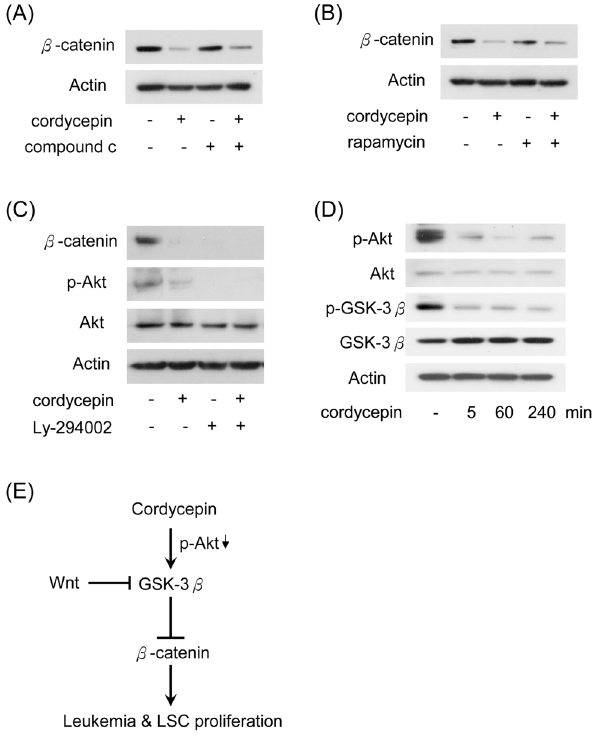
suppressed b -catenin. U937 cells were treated with cordycepin (100 m M) combined with/without (A) compound c (1 m M), (B) rapamy- cin (10 m M) and (C) Ly-294002 (20 m M) for 4 hrs. Expression level of b - catenin, Akt phosphorylated Akt (Ser473) were determined by Western blot analysis. Actin was used as loading control. (D) U937 cells were treated with cordycepin (100 m M) for 5, 60 and 240 min. Expression level of phosphorylated Akt (Ser473), Akt, phosphorylated GSK-3 b (Ser9) and GSK-3 b were determined by Western blot analysis. Actin was used as loading control. (E) A schematic model illustrating the role of cordycepin in suppressing b -catenin in leukemia cells.